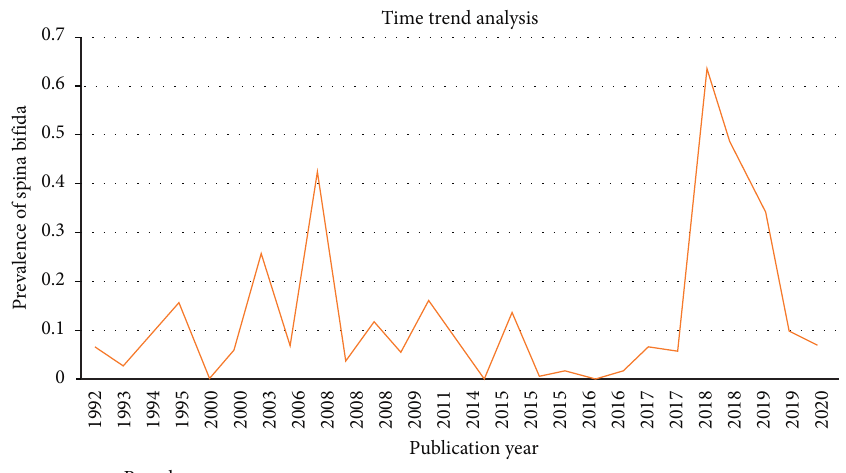
Figure 5: Time trend analysis of the prevalence of spina bifida in relation to the publication year in Africa,